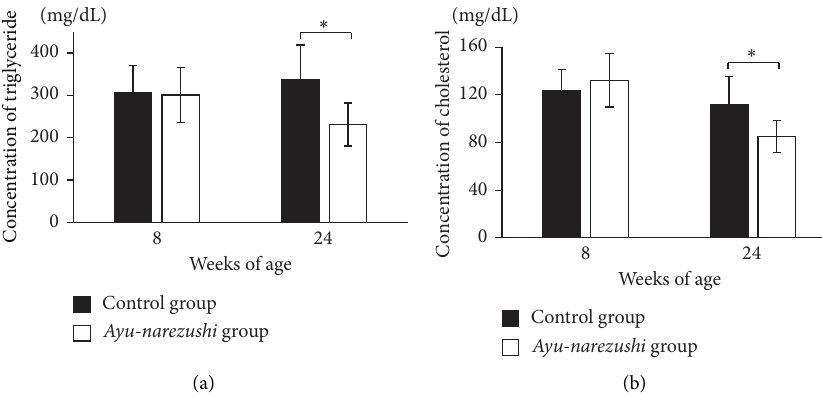
Figure 3: Comparison of serum concentrations of triglycerides (a) and cholesterol (b) at 8 and 24 weeks of age in TSOD mice fed the ayu- narezushi -containing or the control chow. Serum triglyceride levels are significantly lower at 24 weeks of age in the ayu-narezushi group ( n � 5, white column) compared with the control group ( n � 5, black column) (a). Serum cholesterol levels are significantly lower at 24 weeks of age in the ayu-narezushi group ( n � 5, white column) than the control group ( n � 5, black column) (b). The serum triglyceride and cholesterol levels are comparable between the two groups at 8 weeks of age. Variables are expressed as means ± standard deviation. Means were compared using Student’s t test. ∗ P < 0.05.